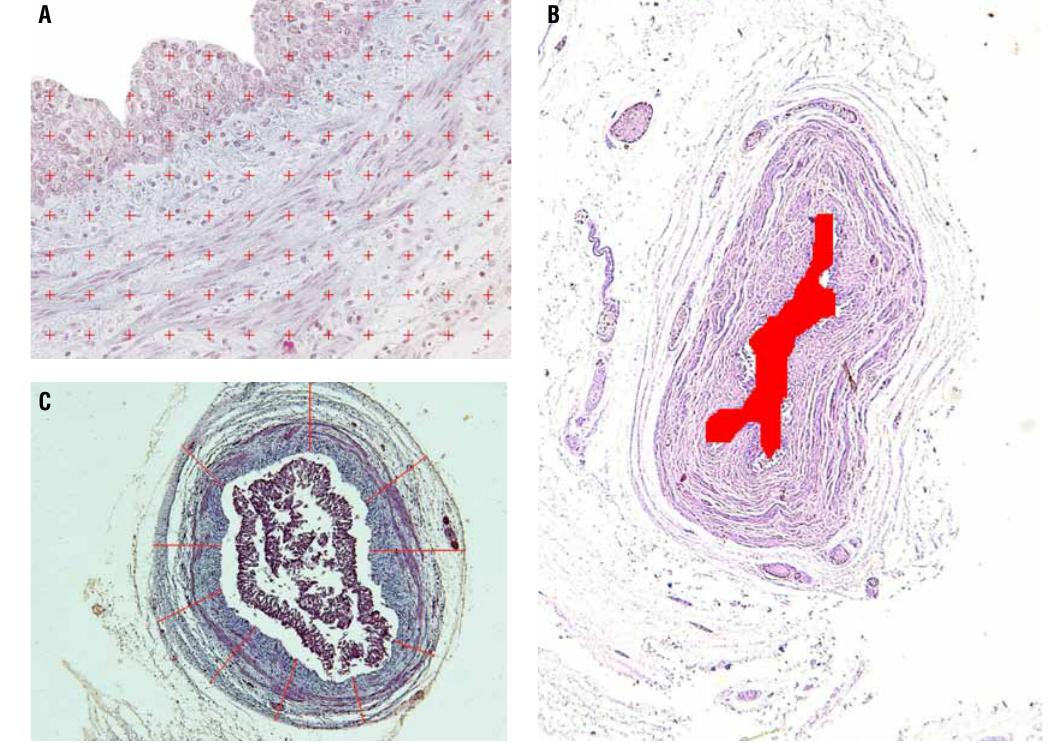
Figure 1 - Morphometric analysis of the fetal ureter. A) Photomicrograph showing quantification of smooth muscle cells of the ureter in a fetus of the control group with 16 WPC using the software Image J Test grid. Masson’s trichrome X400. B) Photomicrograph showing the measurement of the ureter lumen area in an anencephalic fetus with 30 WPC. HE X40. C) Pho- tomicrograph showing the ureter thickness in a fetus of the control group with 27 WPC. Masson’s trichrome